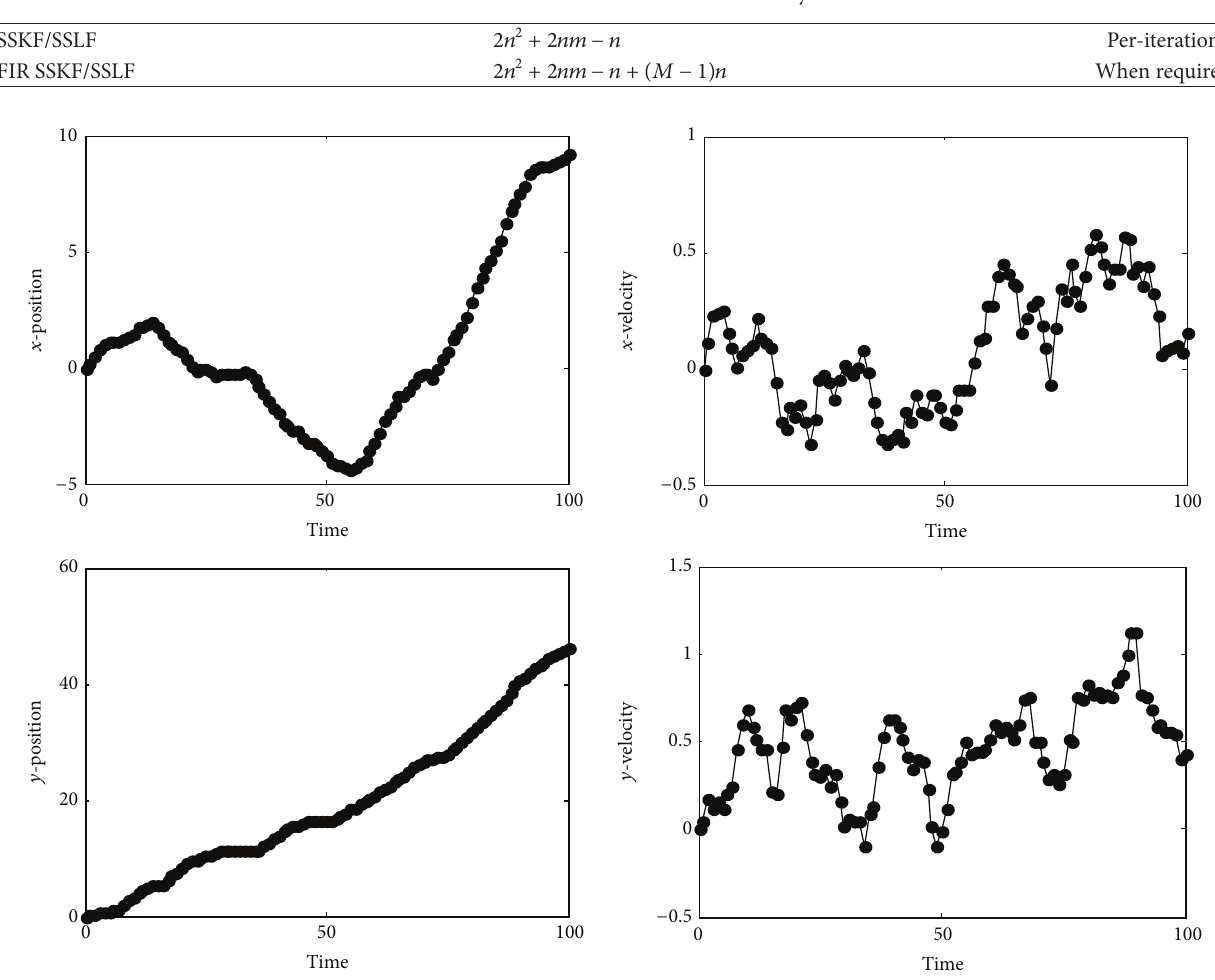
Table 5: Calculation burden of classical and FIR Steady State filters.